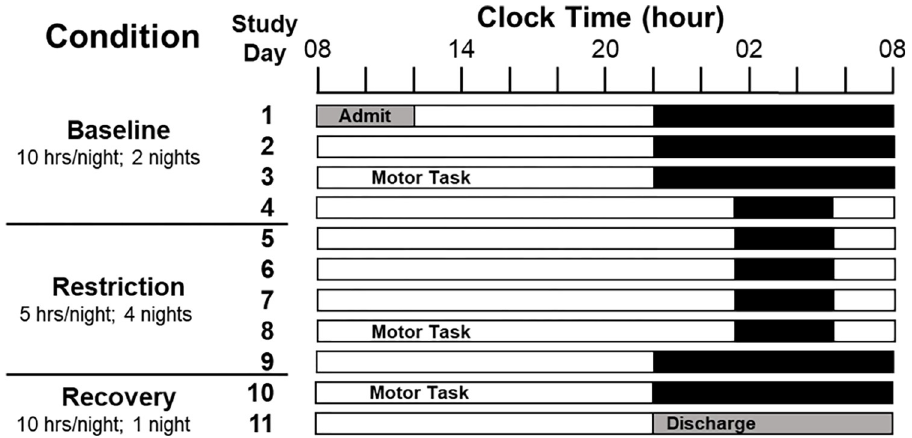
Fig 1. Experimental timeline adapted with permission from Ness et. al., 2019. White bars indicate time awake and black bars indicate time in bed. Participants completed motor task testing after 2 nights of 10-hours in bed (baseline condition); after four nights of 5-hours in bed (restriction condition); and for a third and final time after one night of 10-hours in bed (recovery